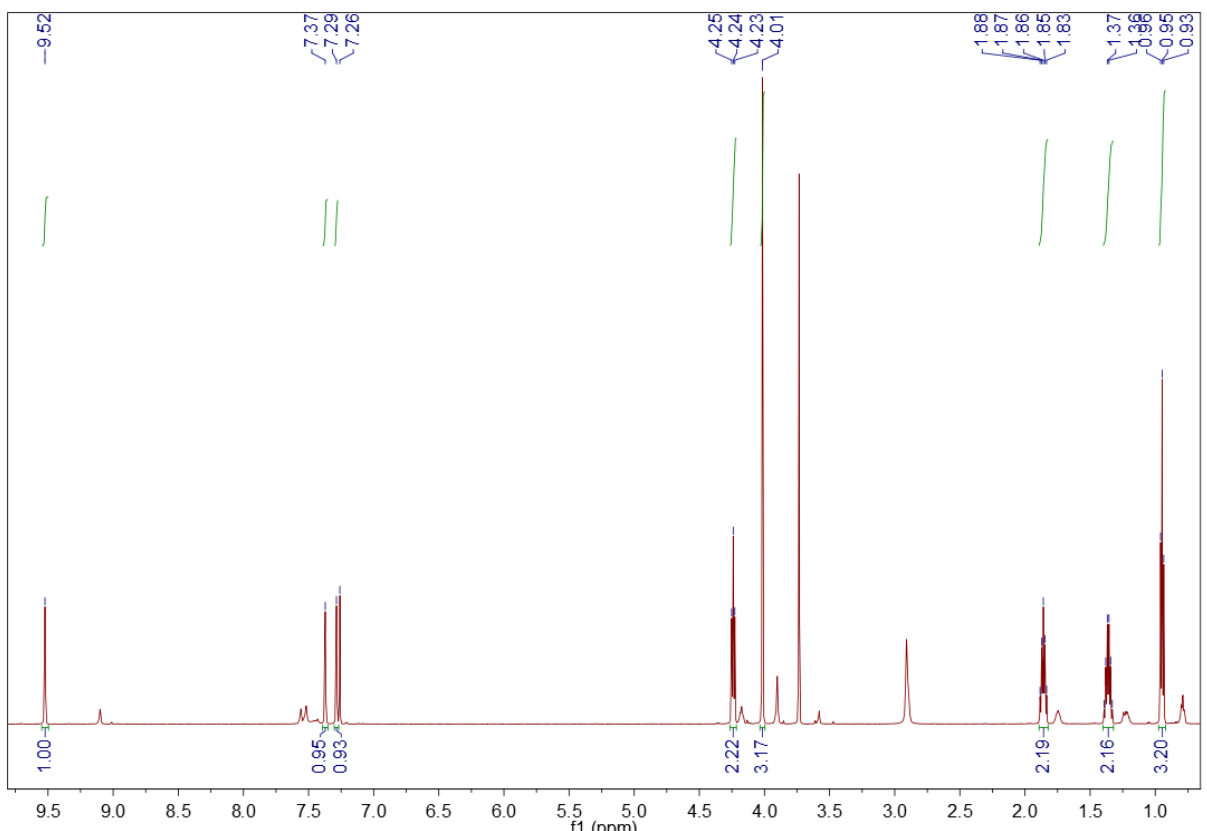
Figure 5. 1 H NMR spectrum of the fresh [BMIM][HSO 4 ]. Sample of 10 mg in 0.7 mL deuterated chloroform, 600 MHz [45].